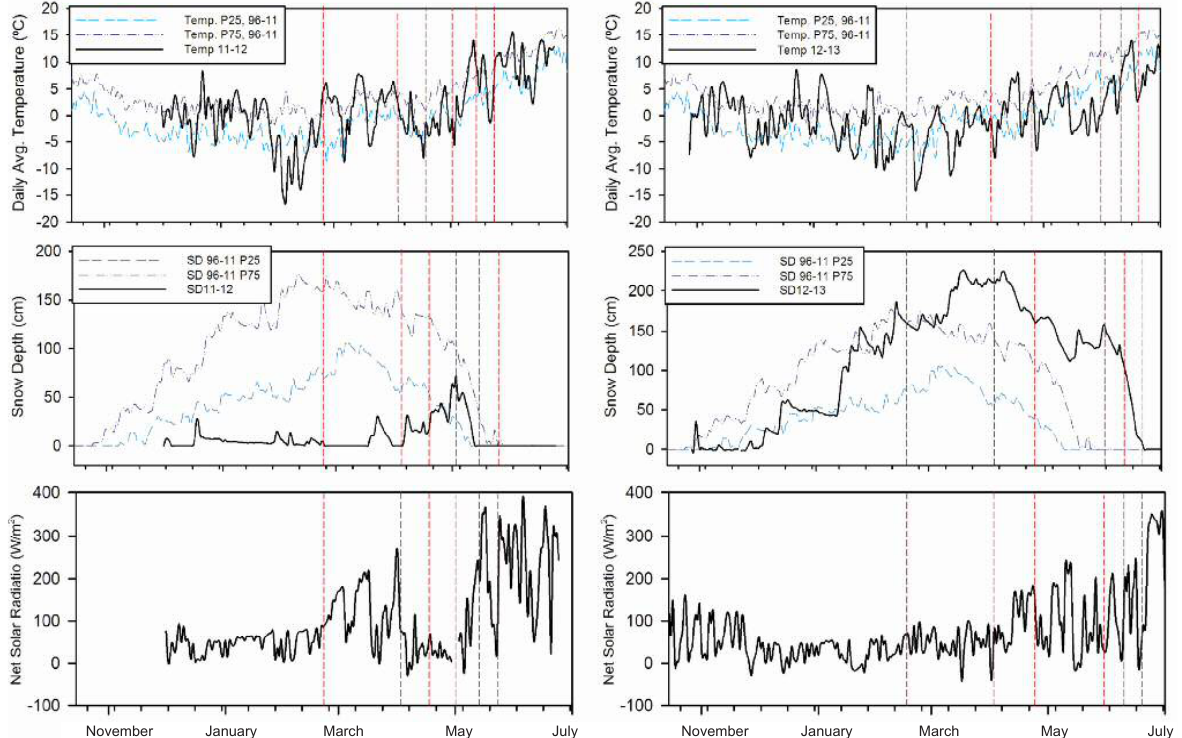
Figure 2. Daily average temperature, snow depth and net solar radiation (shortwave) at the automatic weather station (AWS) for the 2012 (left) and 2013 (right) snow seasons. The continuous lines represent the daily values for 2012 and 2013, and the dashed lines show the 25th and 75th percentiles of historical daily series (1996–2011). The vertical dashed lines show the TLS survey days. Note that during some surveys no snow was present at the AWS, but some areas of the Izas experimental catchment were covered by snow.